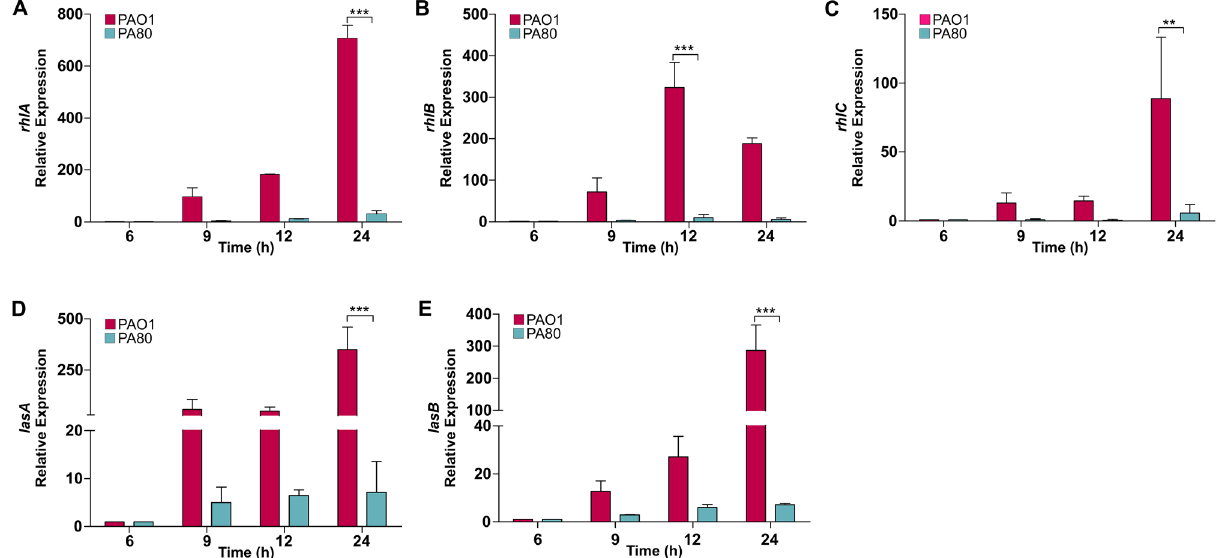
Figure 6. Repression of QS genes attenuates virulence factor production in PA80. Relative expression levels of QS regulated virulence genes ( A ) rhlA, ( B ) rhlB, ( C ) rhlC and ( D ) lasA and ( E ) lasB in both PAO1 and PA80. Expression levels are shown as the mean relative expression ratios to log phase levels (i.e. 6 h). Error bars represent the S.D (biological triplicates). Data was analysed using anone-way ANOVA followed by a Dunnett’s multiple comparison test comparing each time point to log phase levels (i.e. 6 h) (* p < 0.05, ** p < 0.01, *** p <